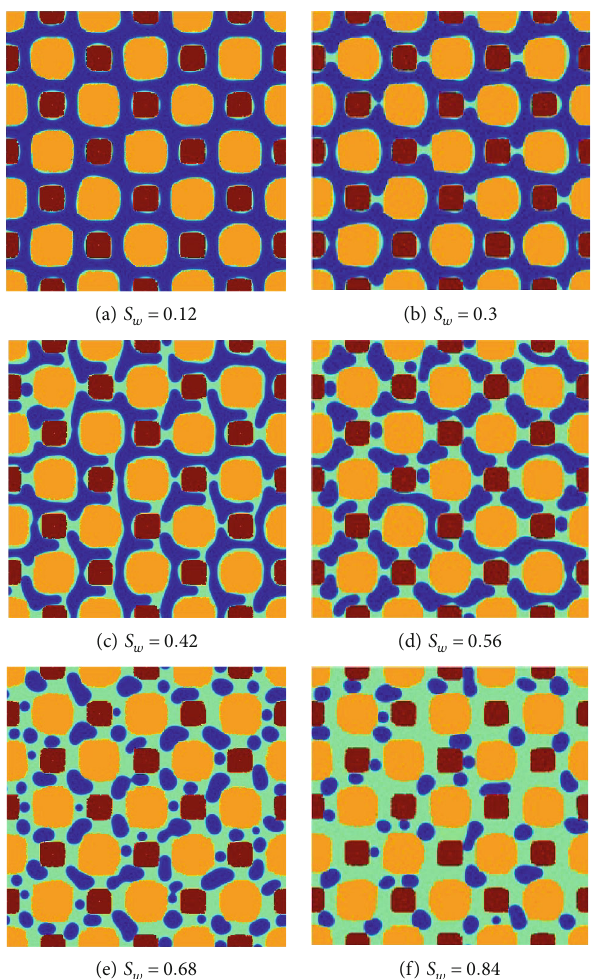
Figure 8: Gas-water dual-phase distribution patterns in HBS. The gas is shown as blue, water as light green, solid particles as orange, and = 0 : 2 , pore- fi lling. hydrate as red. S h